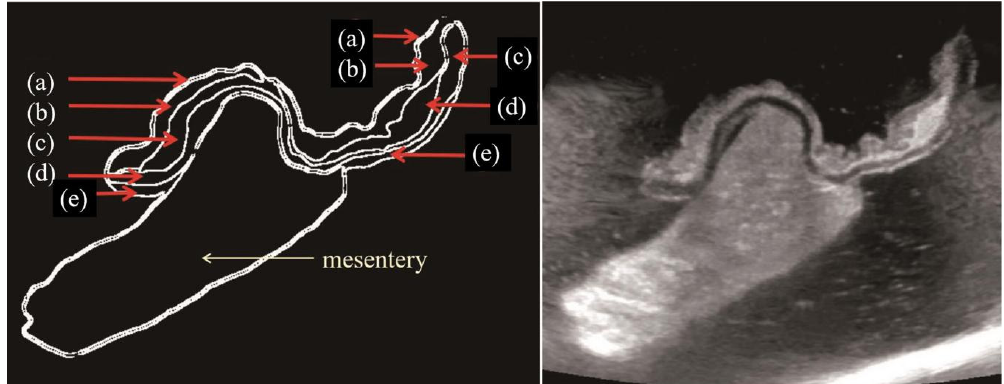
Figure 1. Distinct wall stratification as a five-layer structure in an ileal segment. The resected ileum was incised and opened on the anti-mesenteric border, scanned from the mucosal surface (open view) in transverse view. The right panel shows the image obtained from WIUS, and the left panel is a sketch of the stratification of the bowel wall. The first-to-fifth layers represent the border between ( a ) the lumen and mucosal layer (hyperechogenic); ( b ) the mucosal layer (hypoechogenic); ( c ) the submucosa (hyperechogenic); ( d ) the muscular layer (or the muscle membrane proper) (hypoechogenic); ( e ) and the serosa layer (hyperechogenic).